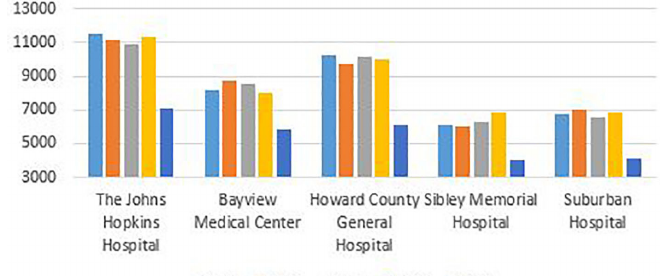
Figure 2. Johns Hopkins Health System ED Visits, March 16